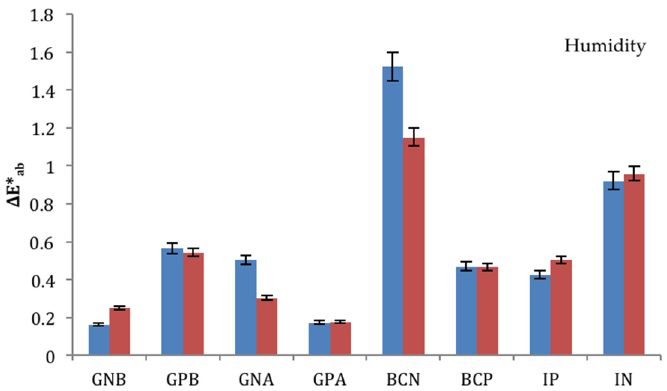
Figure 4. Total colour changes ( ∆ E * ab ) in the humidity ageing tests. Blue bars represent the differences after three cycles. Orange bars represent to the differences after five cycles. The sample codes are explained in Table 1.